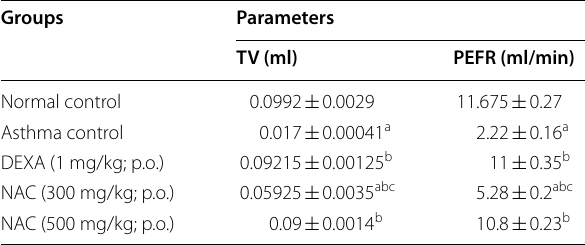
Table 1 Effects of NAC as compared to the reference treatment DEXA on TV and PEFR in asthma rats